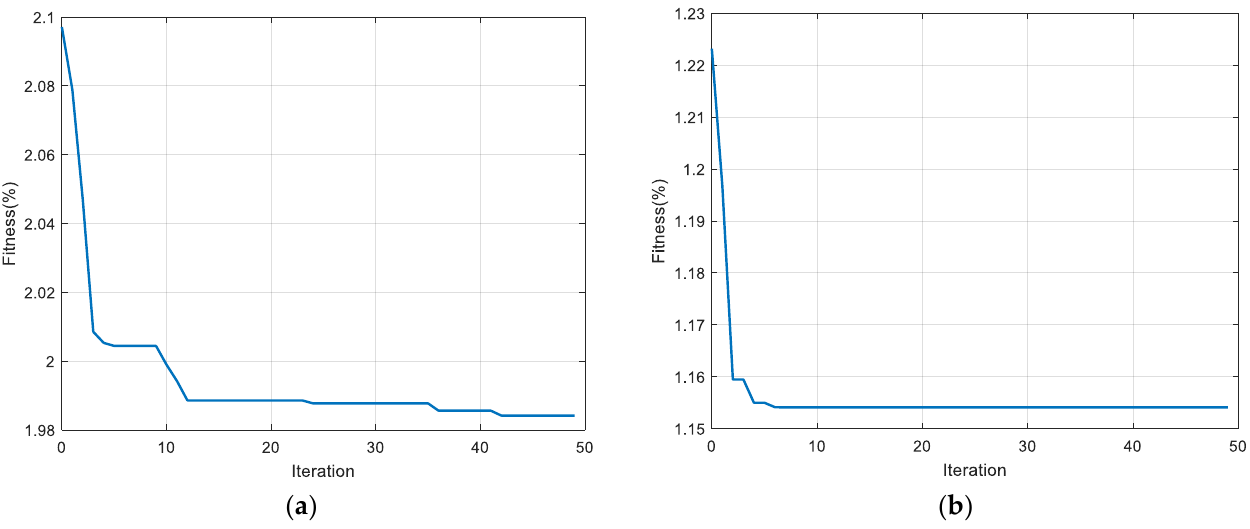
Figure 6. Iterative optimization processes of battery pack and cell. ( a ) Battery pack; ( b ) battery cell.